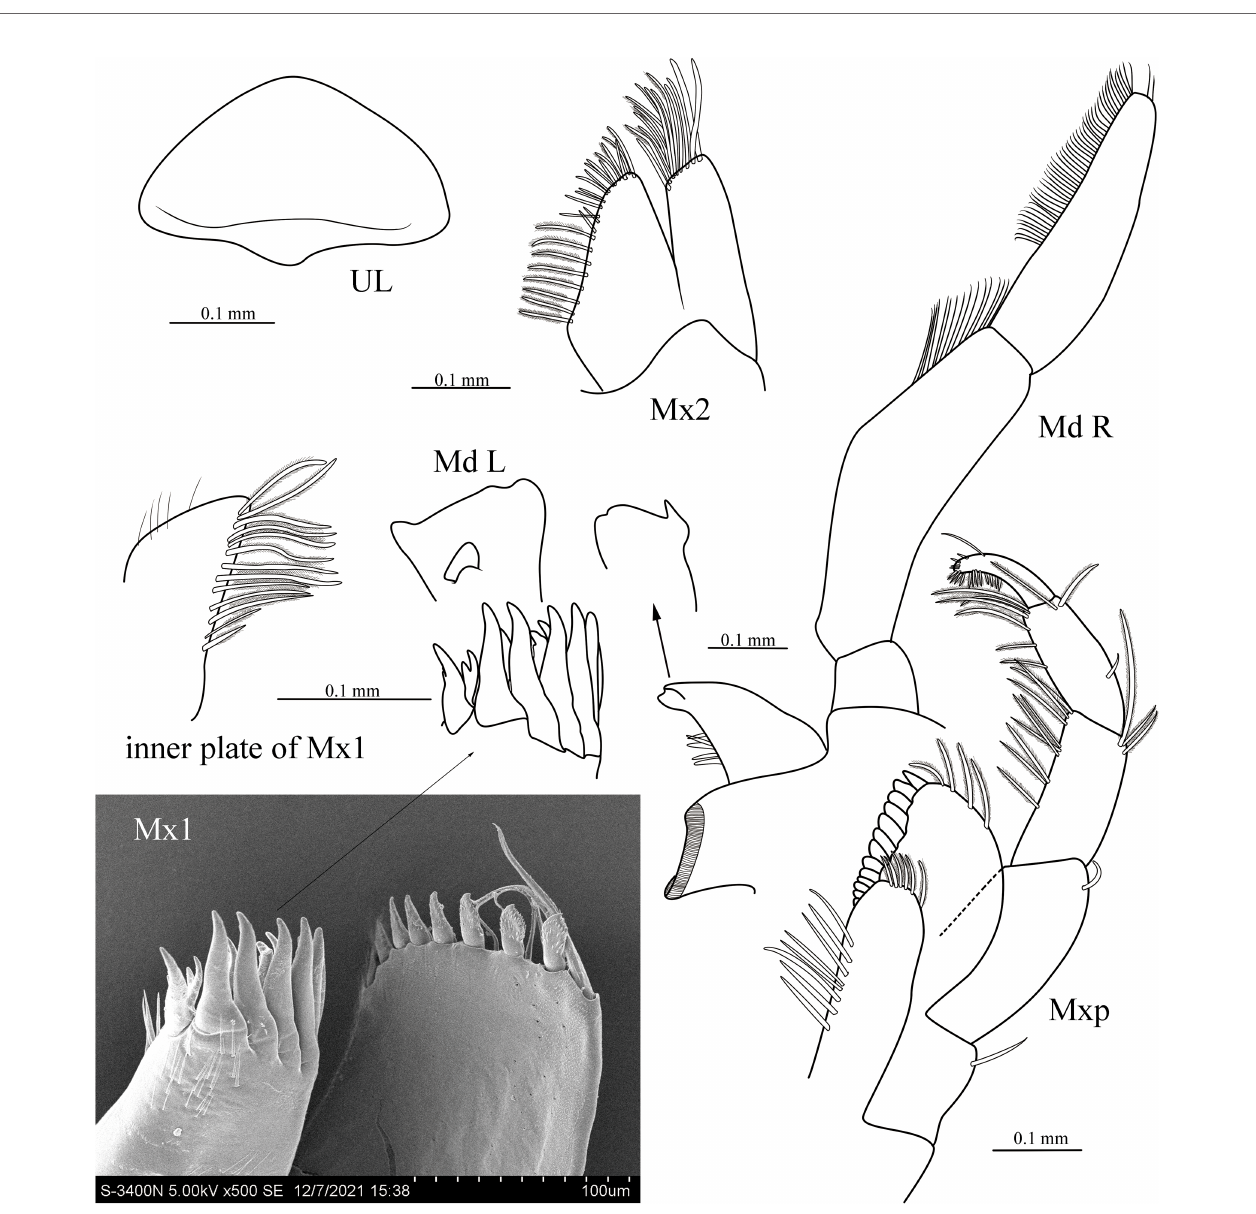
FIGURE 4 | Cyphocaris lubrica sp. nov., MBM 286819, male holotype (9.1 mm), showing mouthparts, SEM picture showing outer plate of distal part of outer plate and palp of maxilla 1. For abbreviations, see